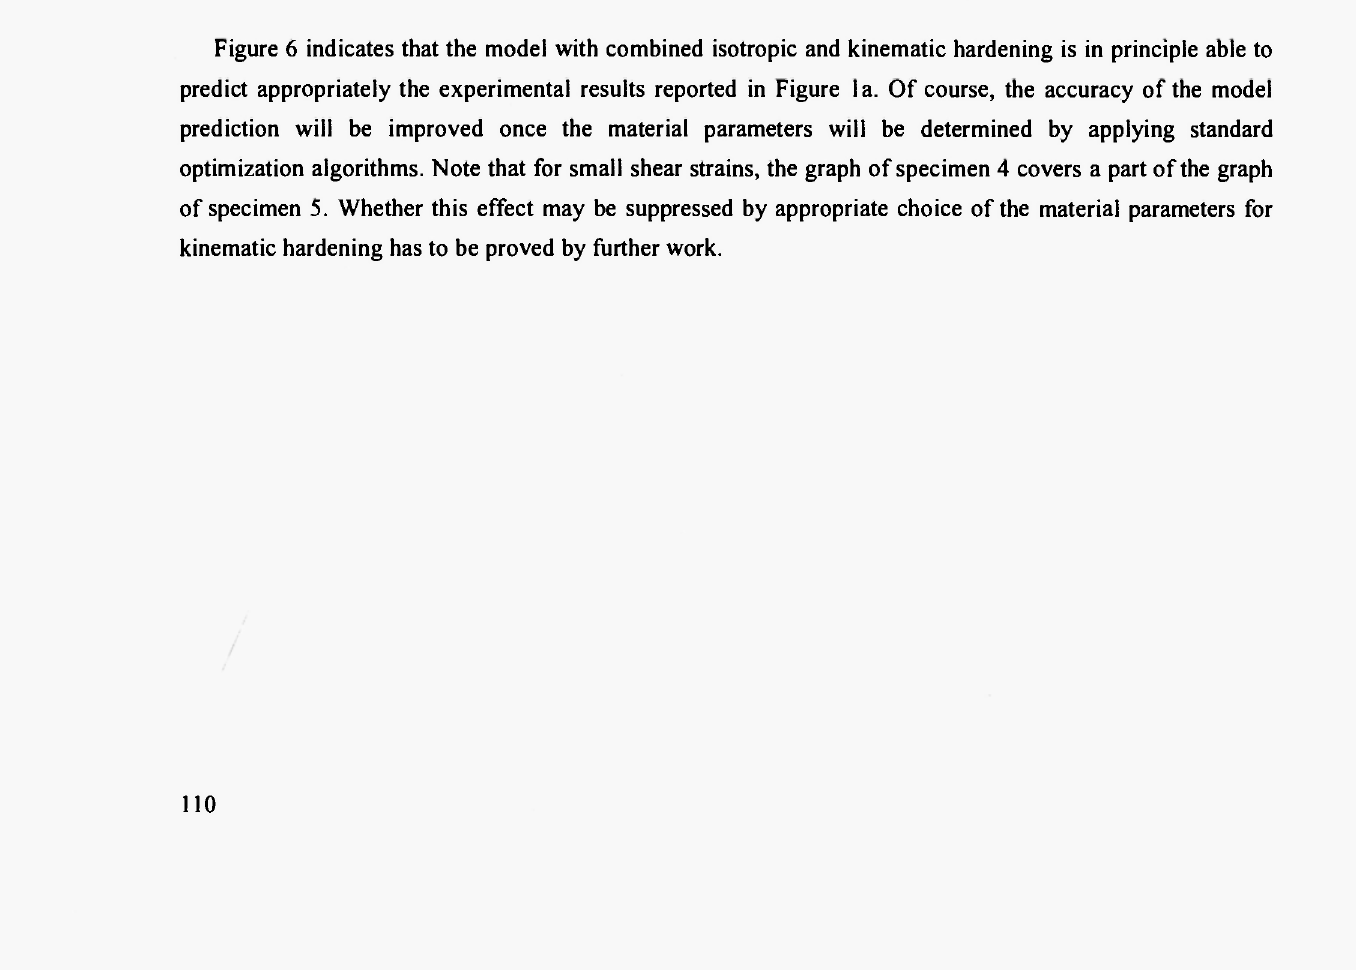
Fig. 5: Predicted torsional responses for pure kinematic